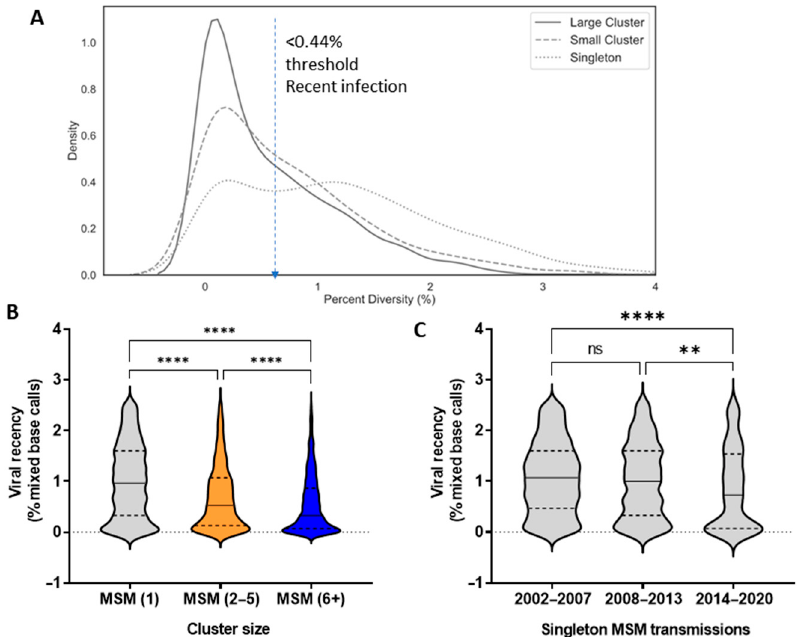
Figure 7. The pronounced role of early-stage infection in onward spread of HIV. ( A ) Frequency distribution of the baseline genetic diversity (% mixed base calls) of MSM infections segregating as singleton transmissions, small cluster (2–5 members), and large cluster (6+) networks. ( B ) Violin plots show the median viral diversity (25th–75th percentile range) of MSM infections within singleton, small cluster, and large cluster networks. ( C ) Changing trends in recency of infection for singleton transmissions arising over the 2002–2007, 2008–2013, and 2014–2019 periods.